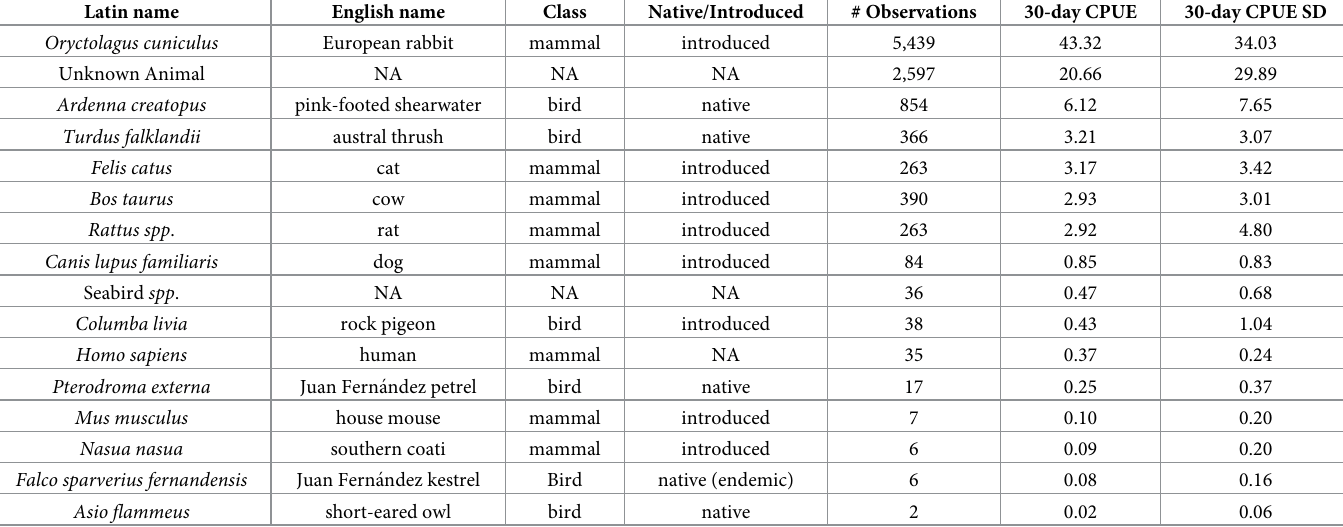
Table 2. Detections of vertebrate animals from four trail cameras at the Piedra Agujereada pink-footed shearwater colony on Isla Robinson Crusoe, Chile, during February 2019-February 2020. Latin